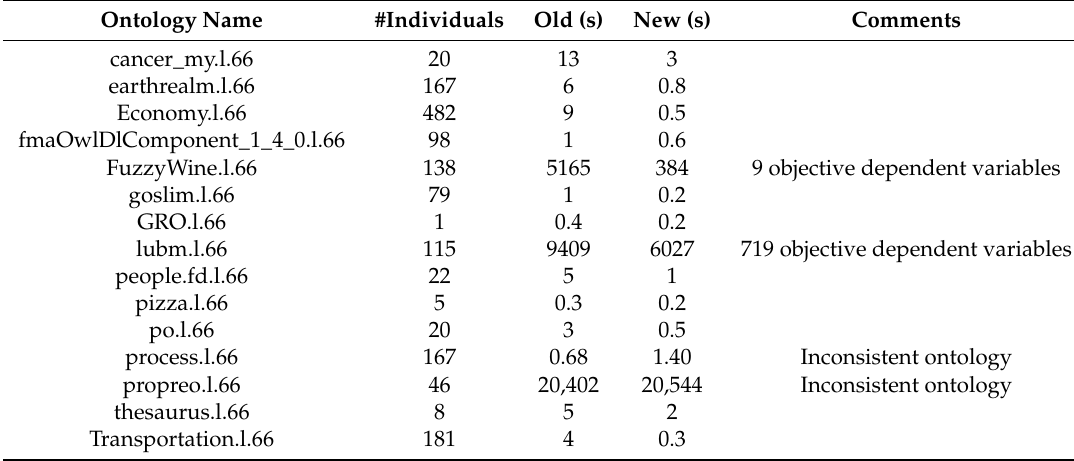
Table 6. Running time (s) for the Absorption